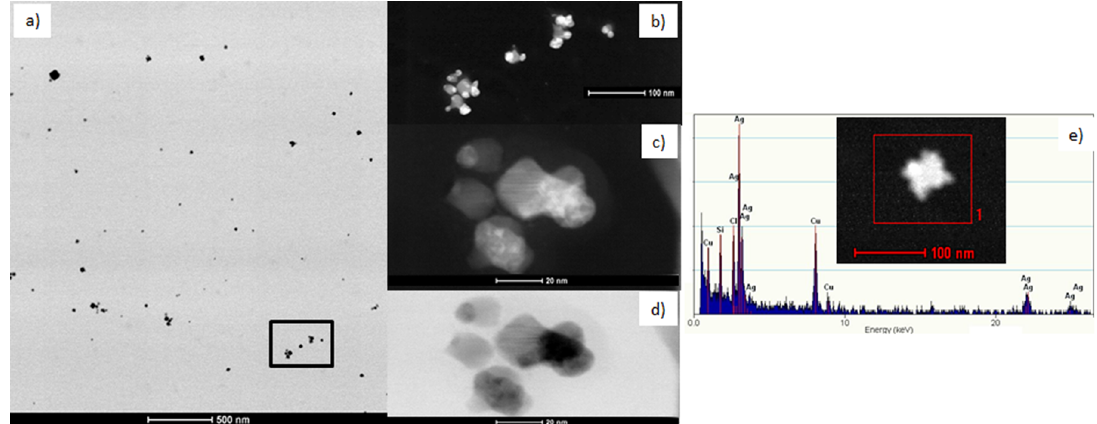
Figure 2. TEM images of AgNPs with different magnifications and contrasts (a, b, c, d); EDS analysis of a single silver nanoparticle